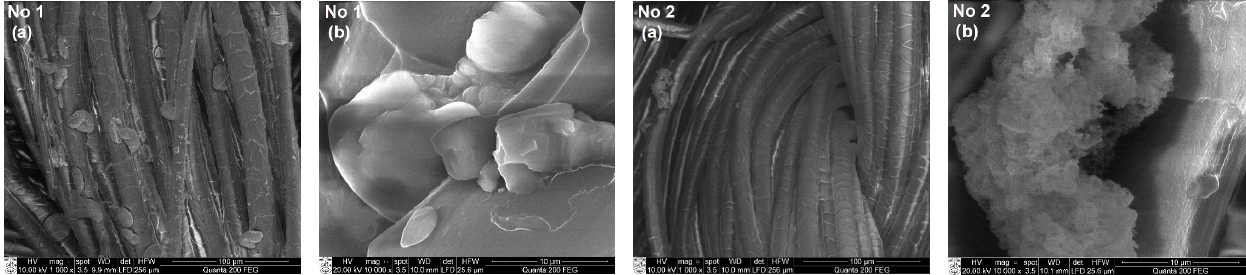
Figure 7. SEM images of knitted fabric material sample T1 (wool, 100) treated with solutions No. 1 Figure 7 and No. 2. Magnification: ( a ) 1000 × ; ( b ) 10,000 ×